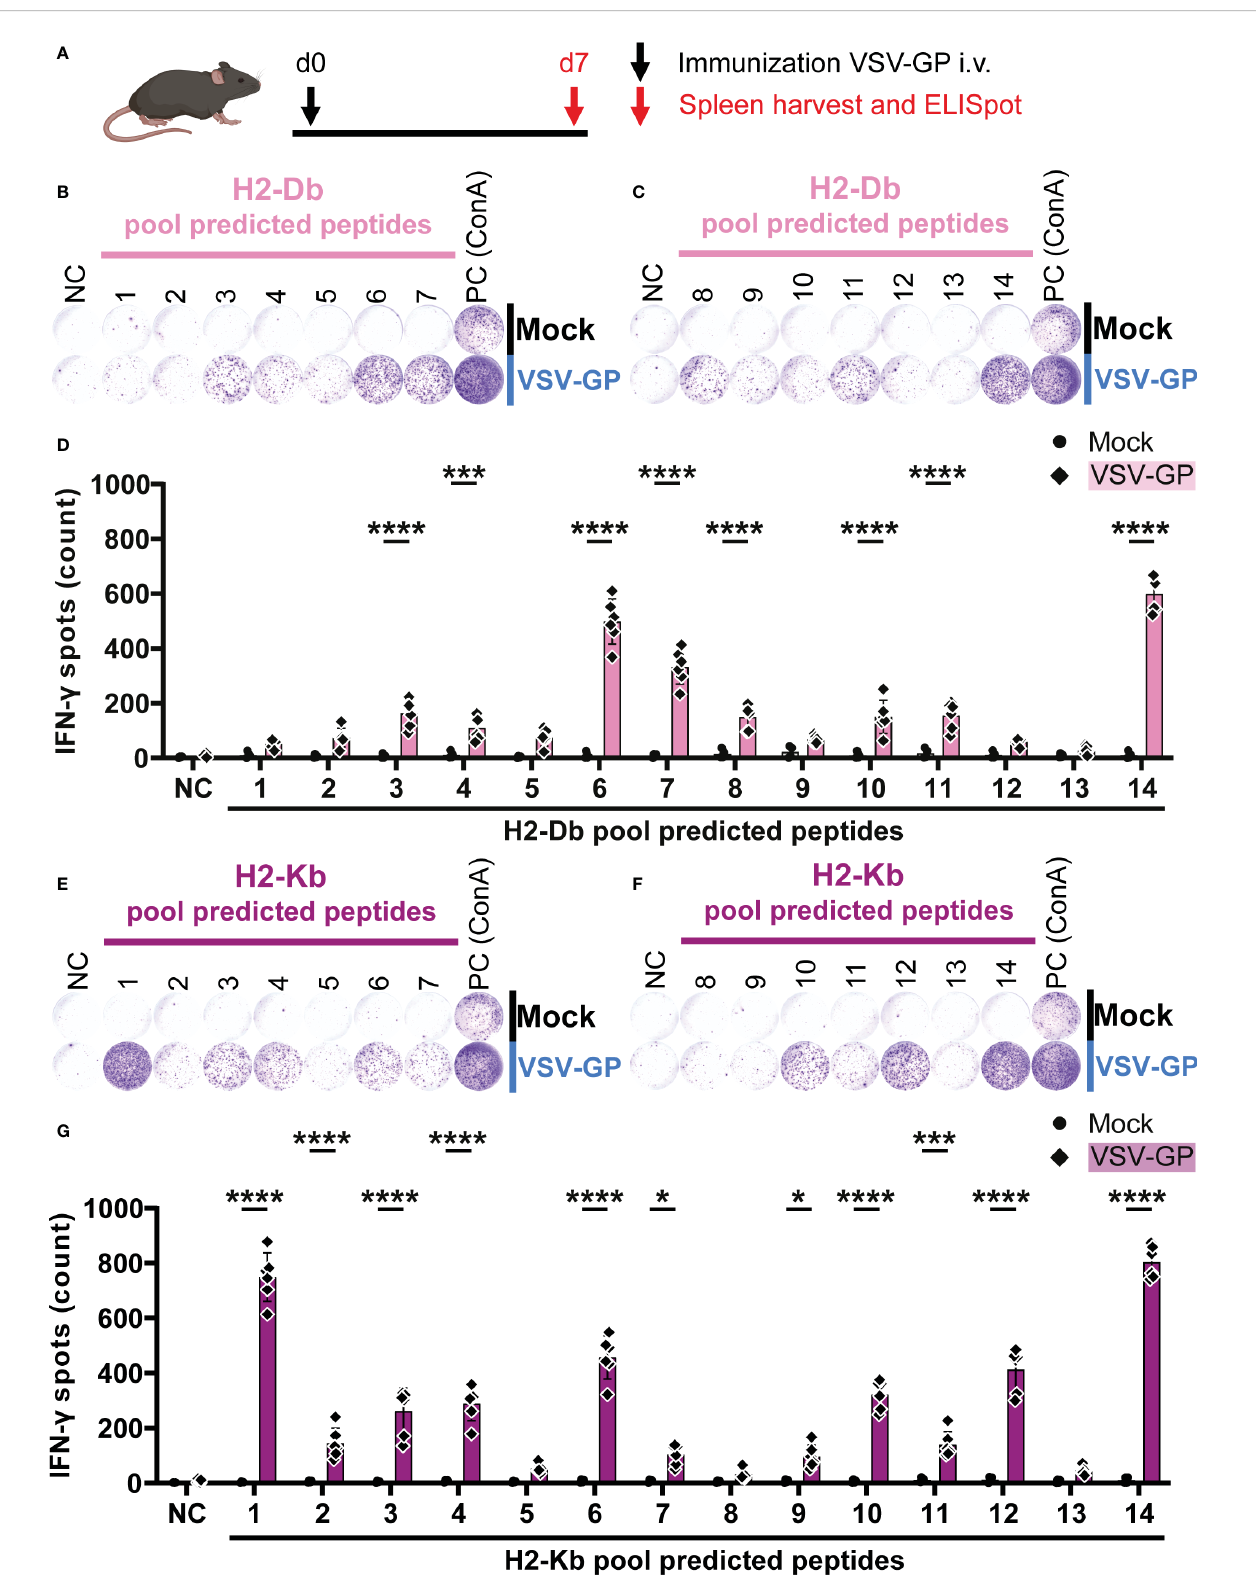
FIGURE 2 H2-Db and H2-Kb peptide pool screening using IFN- g ELISpot identi fi es activating peptide pools. (A) Schematic representation of the experimental setup. C57BL/6J mice were intravenously (i.v.) immunized with VSV-GP on day 0 (d0). On day 7 (d7), spleens were harvested for IFN- g ELISpot. (B,C,E,F) Representative images of IFN- g ELISpots using 2.5 x 10 5 splenocytes per well upon stimulation with 35 µg/ml H2-Db peptide pools 1-7 (B) and 8-14 (C) , and with 35 µg/ml H2-Kb peptide pools 1-7 (E) and 8-14 (F) . The negative control (NC) is unstimulated cells and the positive control (PC) is 5 µg/ml ConA. (D,G) Quanti fi cation of IFN- g ELISpots with H2-Db peptide pools (D) and H2-Kb peptide pools (G) (n=4 for mock, n=6 for VSV-GP, from two independently performed experiments). Signi fi cant differences between mock and VSV-GP treatment are indicated with asterisks (tested using two-way ANOVA with Sidak ’ s multiple comparison). *p < 0.05; ***p ≤ 0.001; ****p ≤